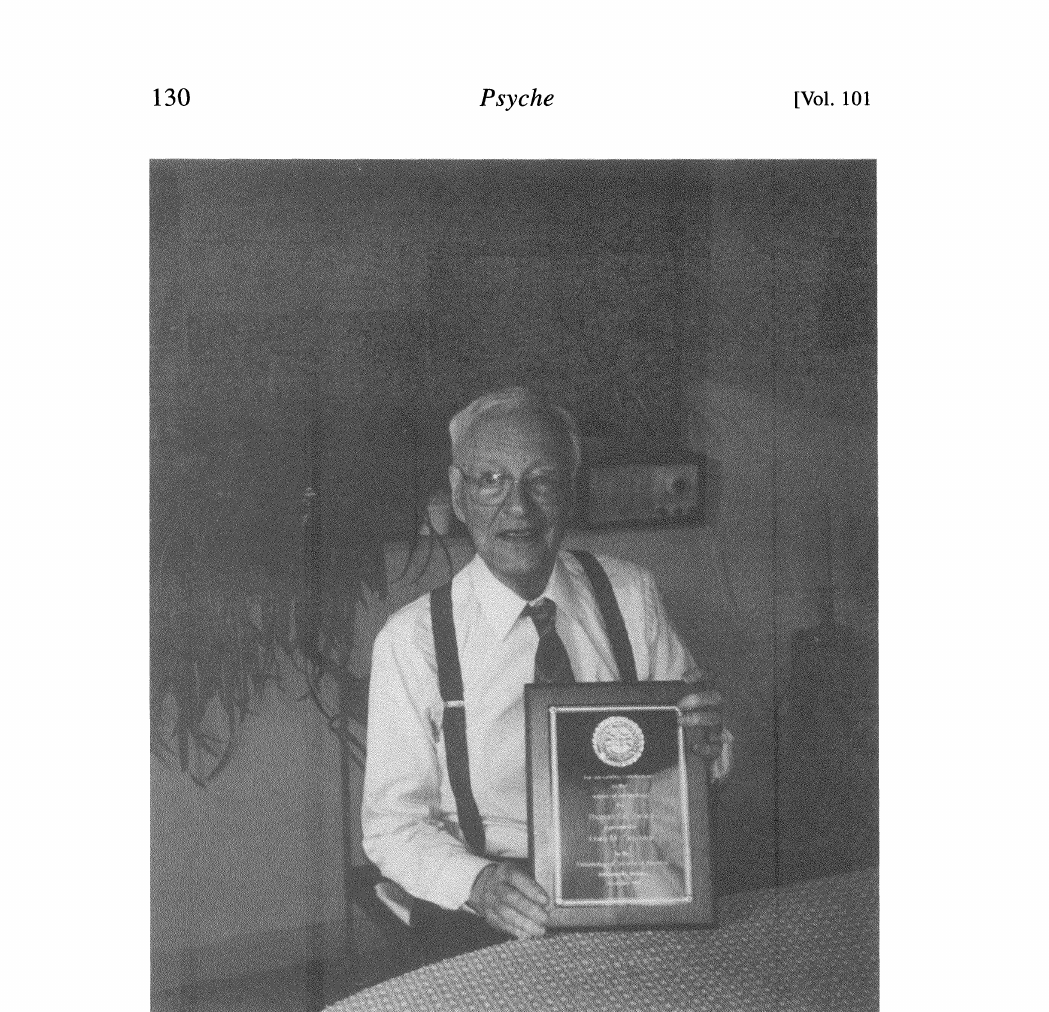
Fig. 1. Prof. Frank M. Carpenter holding the Thomas Say Award, from the Ento- mological Society of America awarded in December 1993. This photo taken at his home was the last photo of Prof. Carpenter. (photo 28 December 1993, by David G.